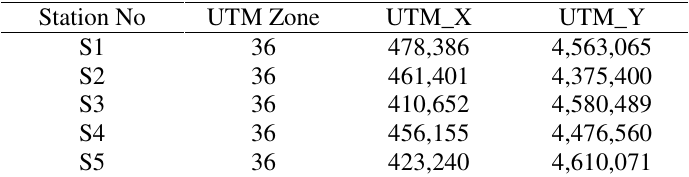
Table 1. Surface water quality monitoring stations